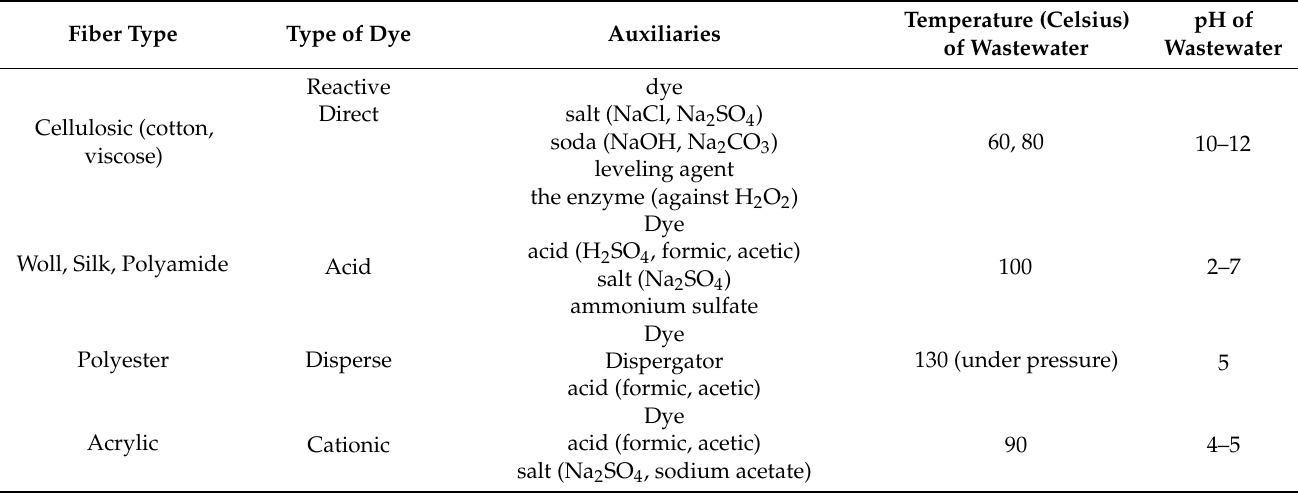
Table 1. Examples of the most common textile fibers processing chemically in dye houses (own study of a different kind of textile treatment from Bilinski Factory